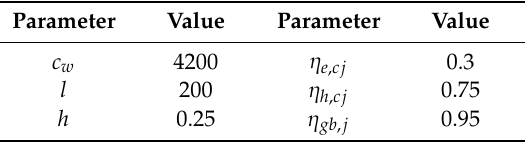
Table 1. Parameters of the heating